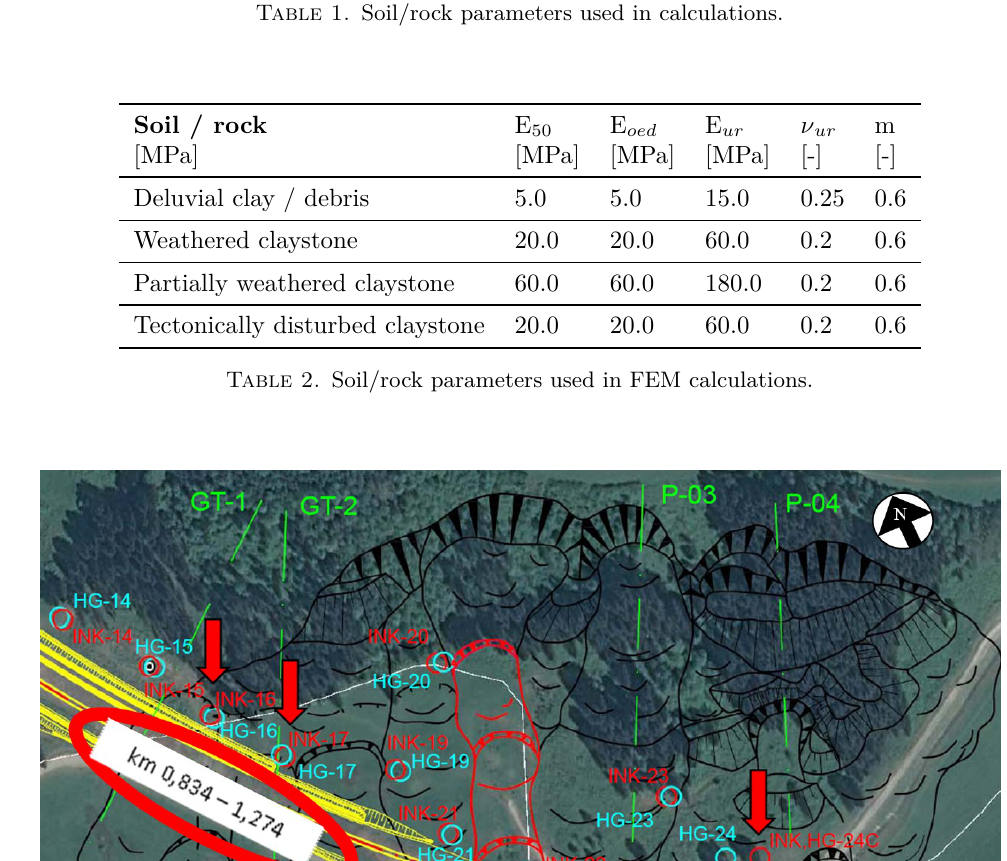
Table 1. Soil/rock parameters used in calculations.